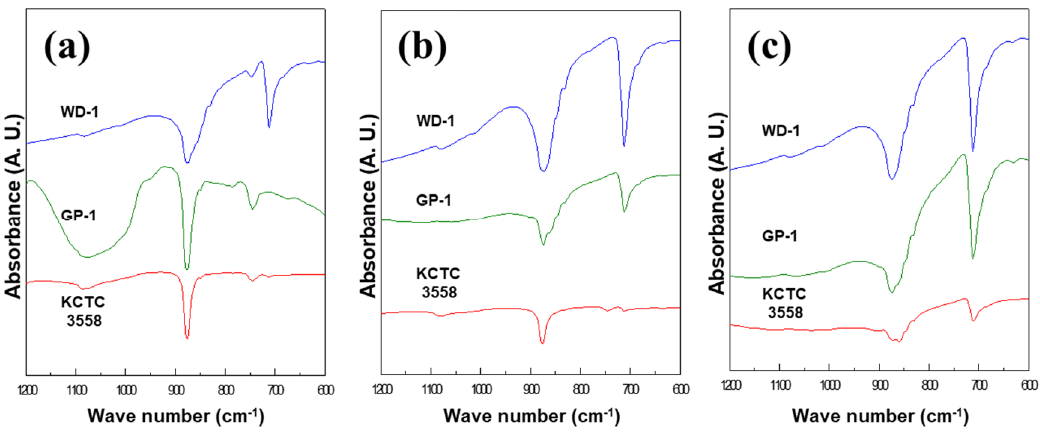
Figure 2. FT-IR spectra showing Ca-carbonate precipitation in di ff erent microbial growth states: ( a ) lag phase or ( b ) stationary phase and ( c ) the SMP solution without cells.